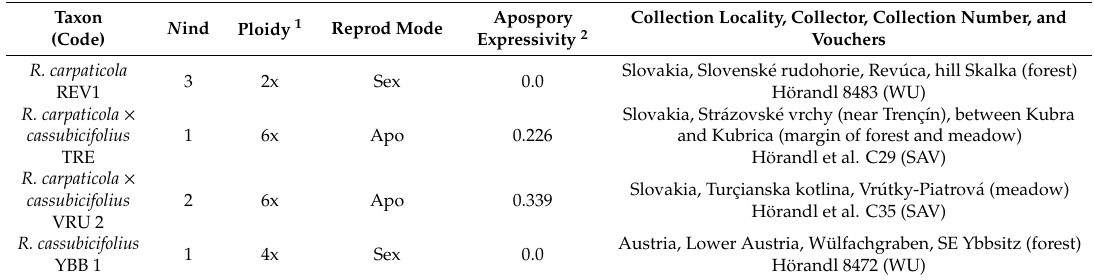
Apospory Collection Locality, Collector, Collection Number, and Expressivity 2